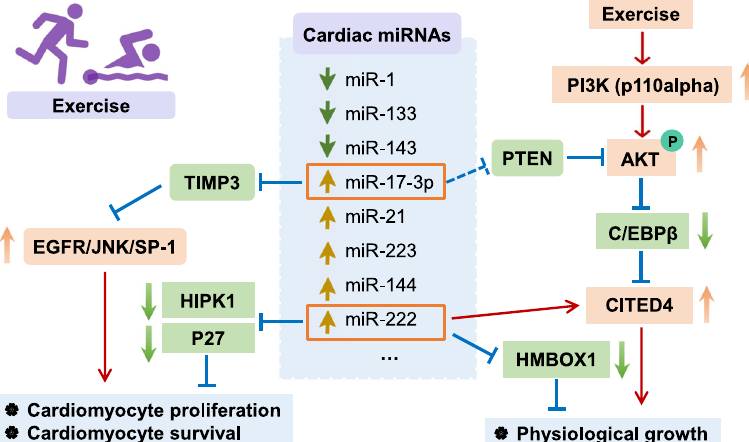
Fig. 3 MiRNAs in exercise-induced cardioprotection. The mechanism of PI3K/AKT, C/EBP- β -CITED4, and cardiac miRNAs (miR-222, miR-17-3p) in exercise-induced cardiomyocyte hypertrophy, proliferation, and survival.